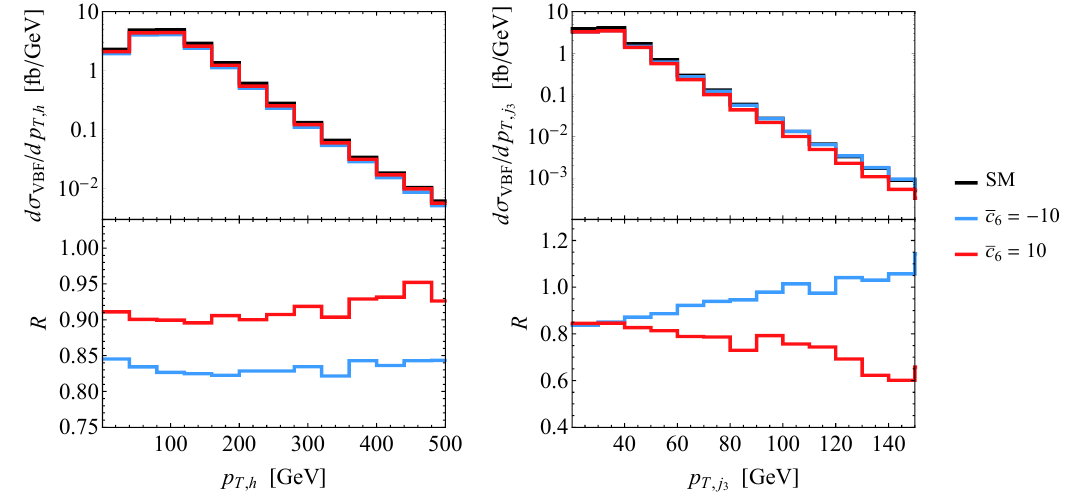
Figure 7 . Comparison of the p T;h (left) and p T;j style and colour coding of the curves follows the one of (cid:12)gure